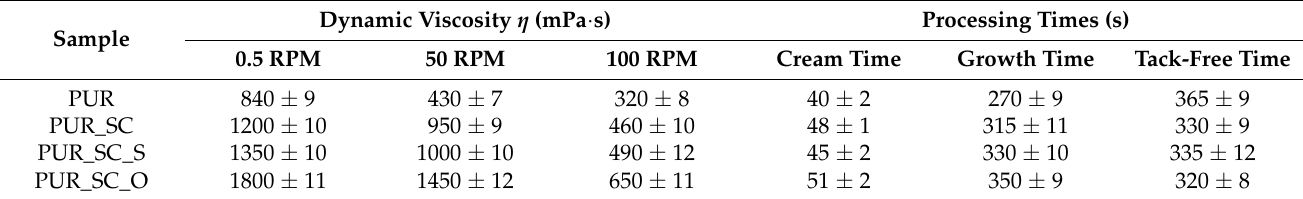
Table 2. The impact of SC fillers on reological and foaming parameters of PUR premixes. Sample